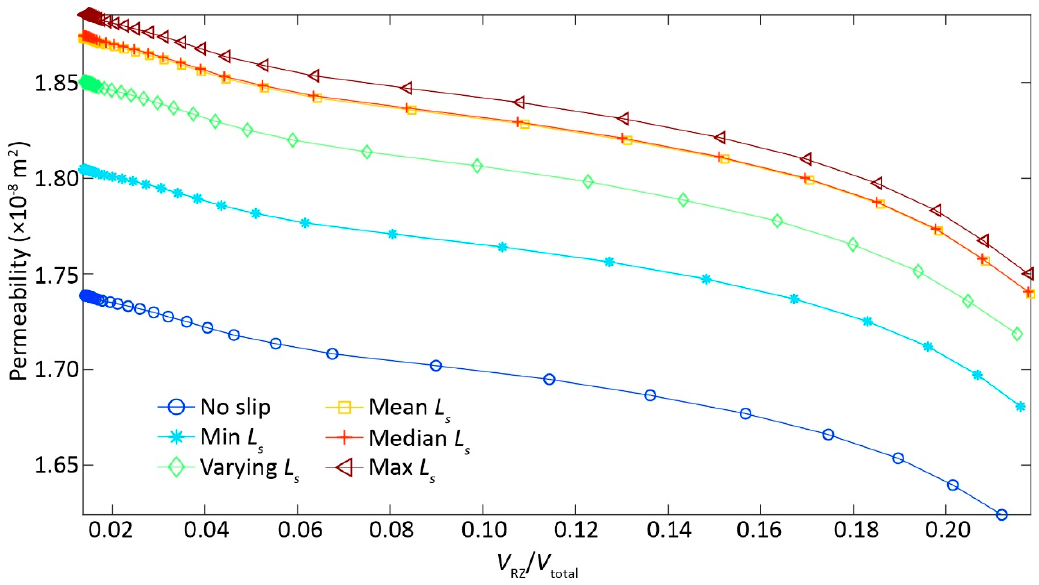
Figure 5. The relationship of permeability with recirculation zone volume ratio ( V RZ / V total ) for six cases with a variety of slip lengths L s : case 1—no slip length with L s equal to 0; case 2—minimum L s assigned in the case 3; case 3—varying L s depending on aperture based on [20,21]; case 4—mean L s assigned in the case 3; case 5—median L s assigned in the case 3; and, case 6—maximum L s assigned in the case 3, where V RZ is circulation volume, V total is the total fracture volume.